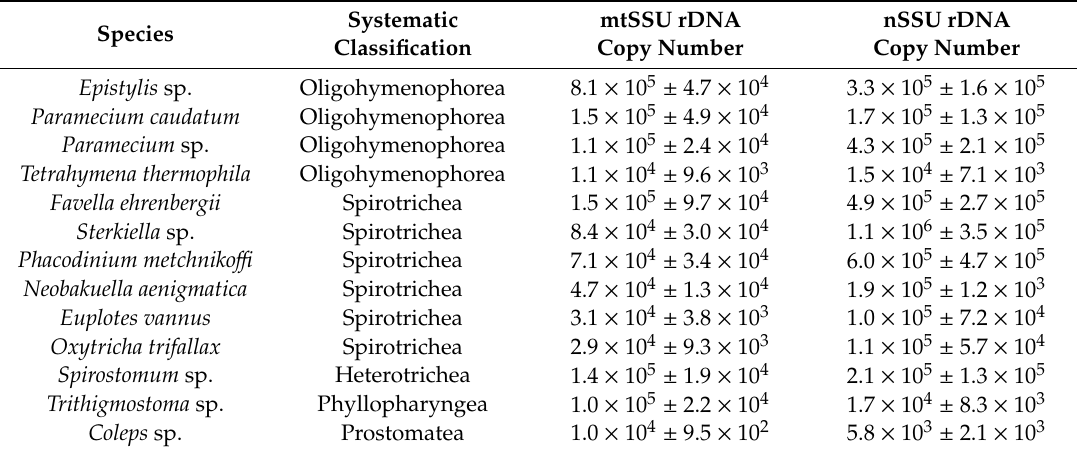
Table 1. mtSSU and nSSU rDNA copy numbers of the 13